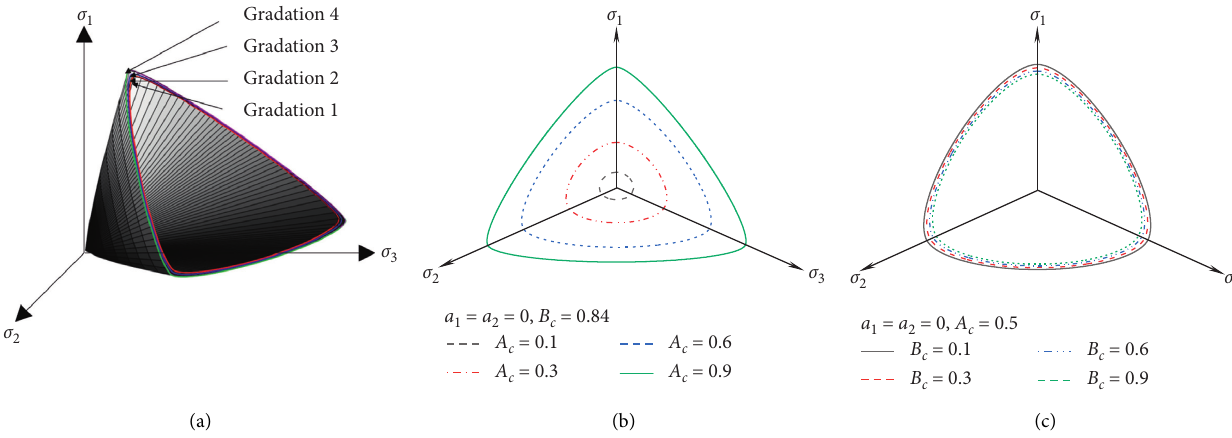
Figure 6: Schematic of various failure surfaces. (a) Failure surface with different gradations. (b) Failure surface with variations of the strength parameter A c . (c) Failure surface with variations of the strength parameter B c .